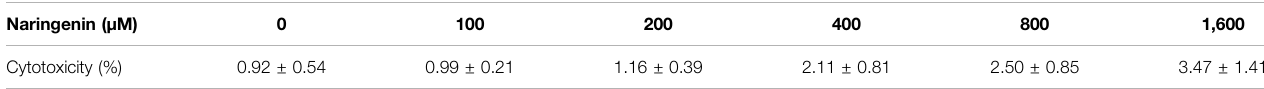
TABLE 1 | Effects of naringenin on cytotoxicity of platelets. Naringenin ( μ M)